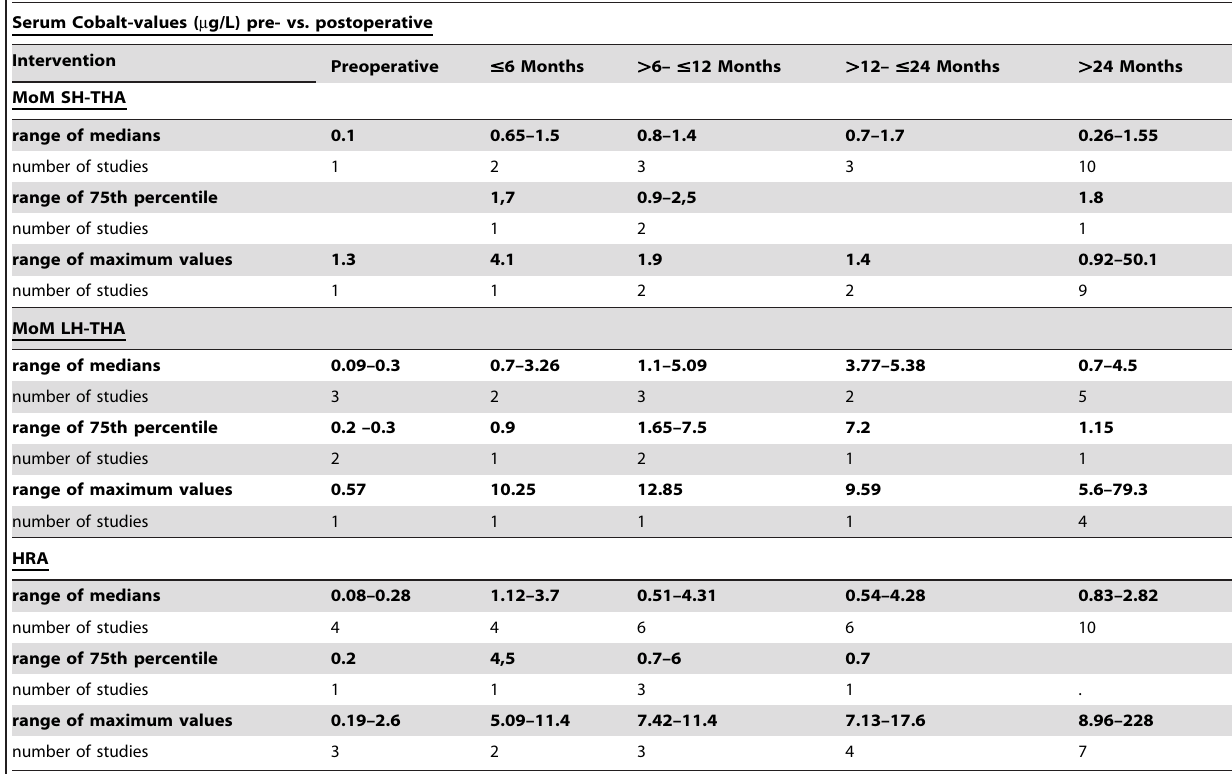
Table 8. Median serum Co concentration in m g/L before and after hip replacement in epidemiological studies.